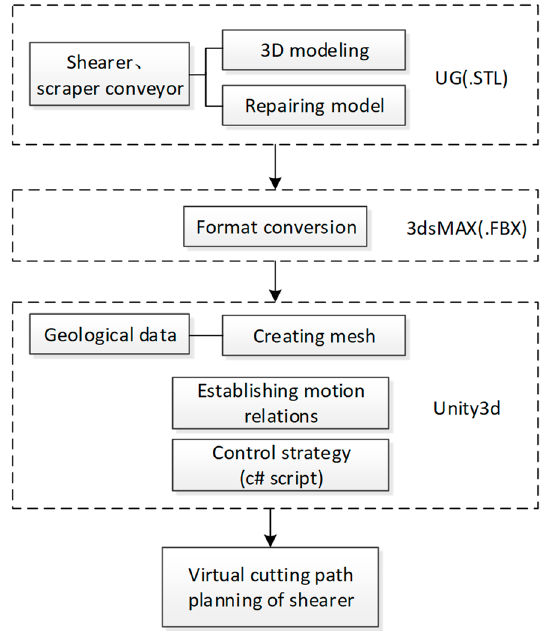
Figure 5. Algorithm of the main process of the virtual cutting of shearer.